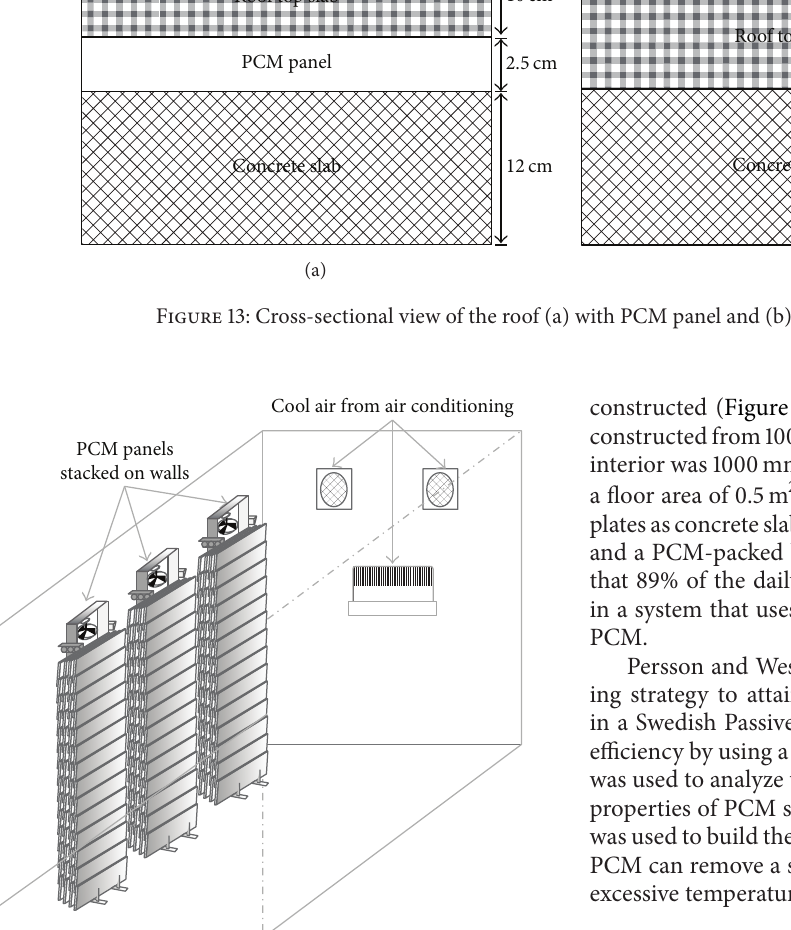
Figure 14: Schematic view of high-density polyethylene panel based TMS in the test